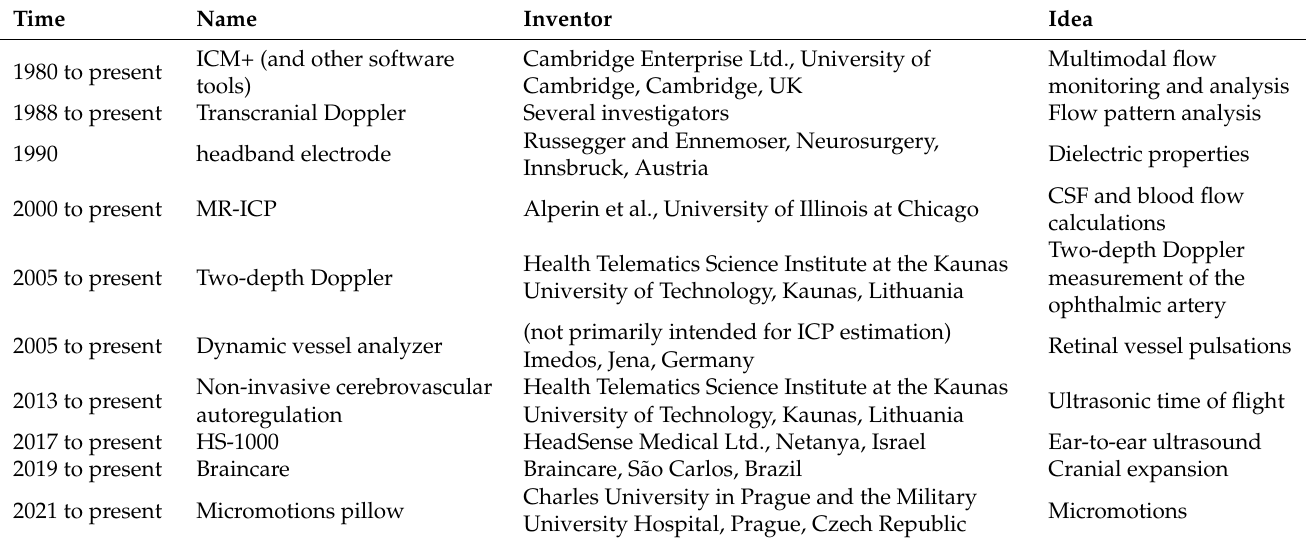
Table 3. Selected devices and